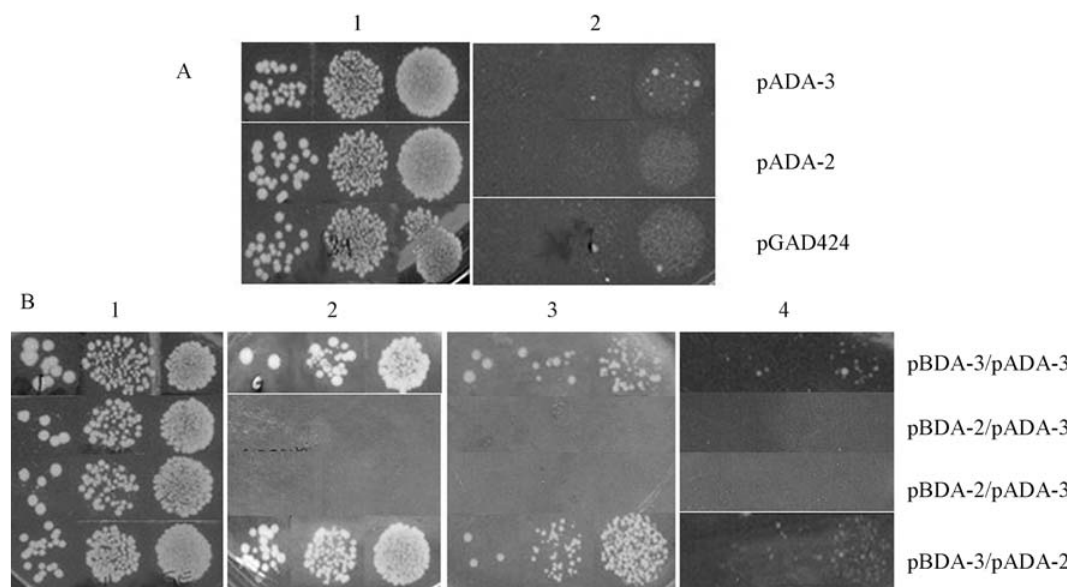
Figure 4 - Two-hybrid 3-AT assay. Drops of HF7c transformant cultures carrying plasmids pADA-3 ( GAL4-AD-mat A-3 ), pADA-2 ( GAL4-AD-mat A-2 ), pGAD424 (vector) (A) , and combinations pBDA-3 ( GAL4-BD-mat A-3 )/pADA-3, pBDA-2 ( GAL4-BD-mat A-2 )/pADA-3, pBDA-2/pADA-2 and pBDA-3/pADA-2 (B) wereappliedonSDsolidmedia. A )SDmediadevoidofleucine( 1 ),forcontrolpurpose,anddevoidofleucineandhistidine( 2 ). B ) SD media devoid of leucine and tryptophan (control) ( 1 ); leucine, tryptophan and histidine ( 2 ); leucine, tryptophan and histidine enriched with 2.5 mM 3-AT ( 3 ) and 5 mM 3-AT ( 4